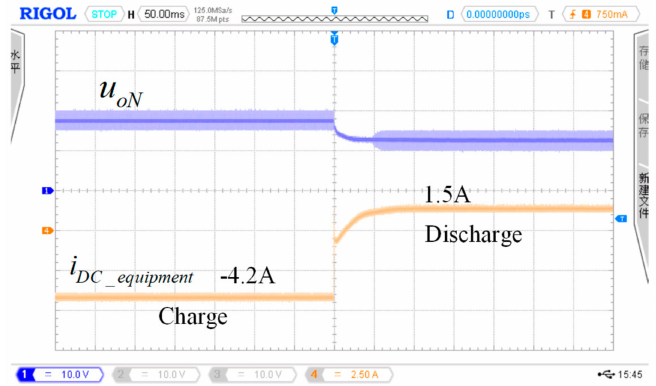
Figure 21. PR port voltage and current under Battery Mode.